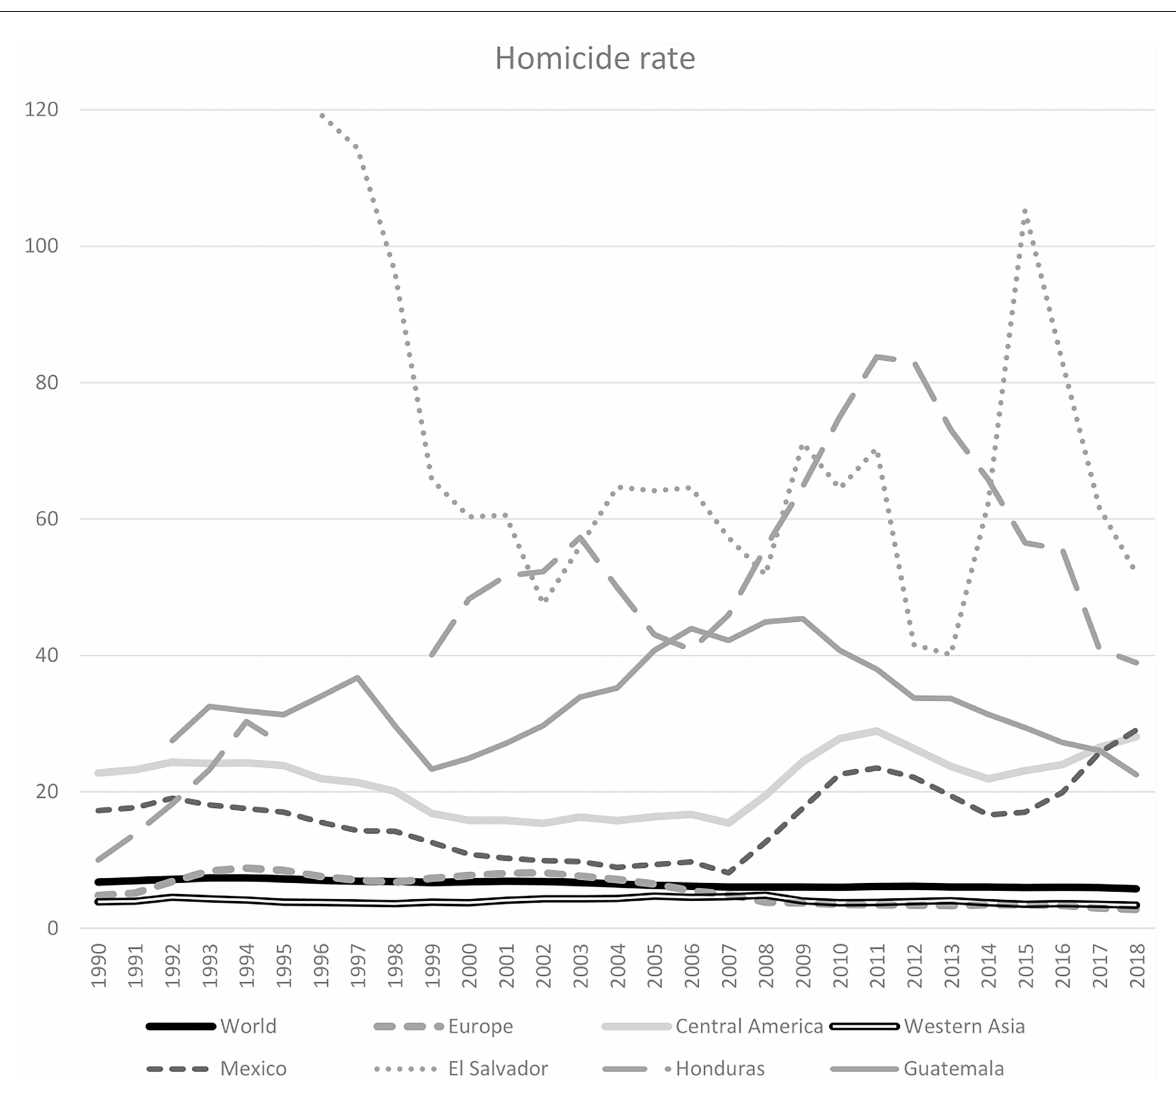
everyday life can vary substantially, as can be seen comparing Syria and Central